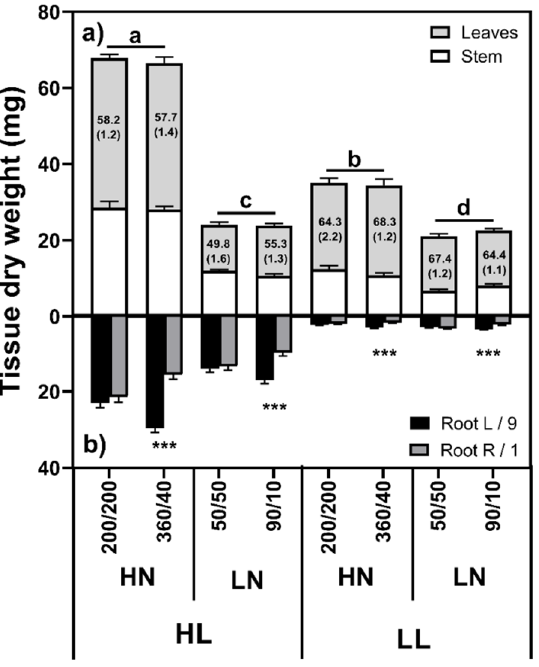
Figure 1. Shoot ( a ) and root ( b ) masses of Poa annua plants grown under high (HL) or low light (LL) conditions and supplied either high (HL: 400 µ g/2 days) or low (LN: 100 µ g N/2 days), distributed either equally (200/200 or 50/50) or unequally (360/40 or 90/10) between root box chambers, where n = 12. Numbers in the bars (means ± SE) indicate the percentage of the shoot mass attributable to the lamina. Different letters in the shoot graphs indicate statistically significant differences between light and nitrogen treatments. Asterisks in the root graphs denote significant differences ( p < 0.001 ***). A significant light by N level interaction on root mass (Figure 1b; F (1,88) = 34.55, p < 0.001) was found, with HL plants having significantly higher root masses than LL plants, both in HN (F (1,88) = 597.74, p < 0.001) and LN (F (1,88) = 259.73, p < 0.001). N